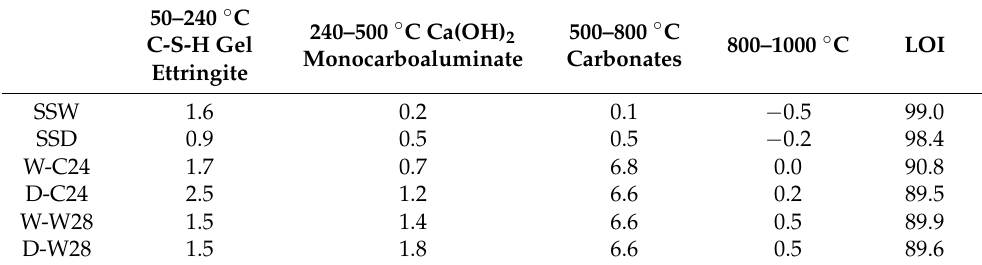
Table 3. Weight loss values for each sample at different temperature